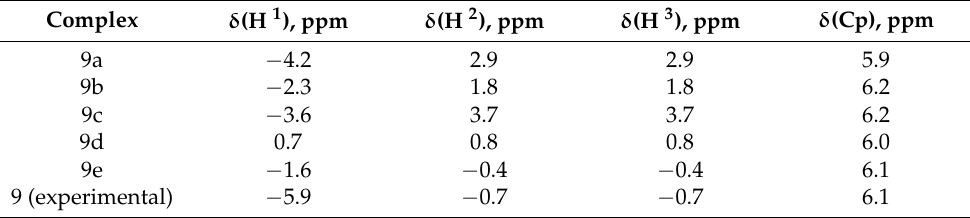
Table 5. Calculated and experimental chemical shifts of isomeric complexes 9a – d (numbering according to Scheme